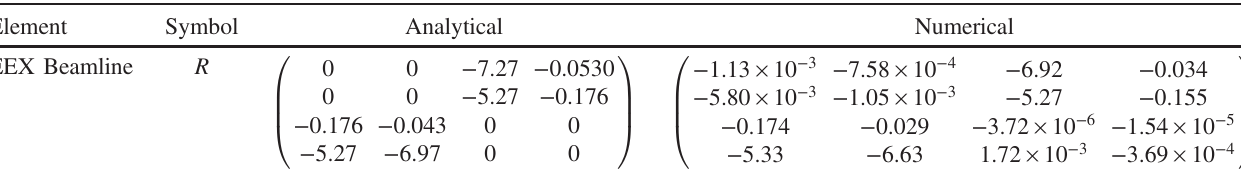
TABLE I. First order transfer matrix. Element Symbol